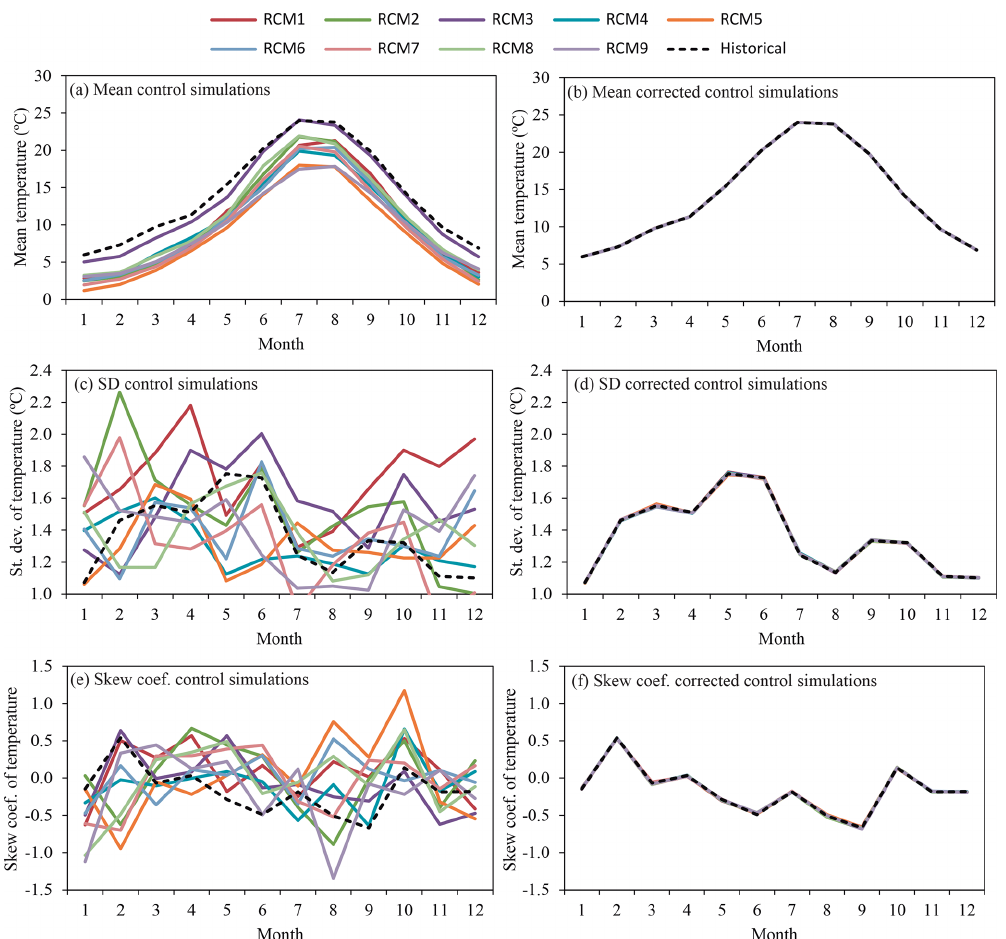
Figure 5. Monthly mean temperature, standard deviation, and skew coefficient of temperature within the mean year of the period (1972–2001) for the historical and control simulation series (a, c, e) and historical and corrected control simulation series (b, d, f)